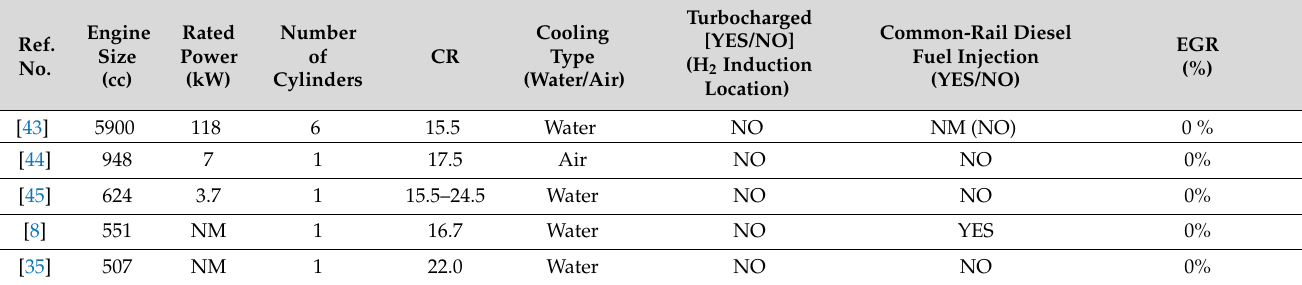
Table 1. Main characteristics of the diesel engines that were utilized by other researchers, according to the examined literature, to investigate the effect of H 2 addition on engine’s performance and emission characteristics. NM corresponds to “Not